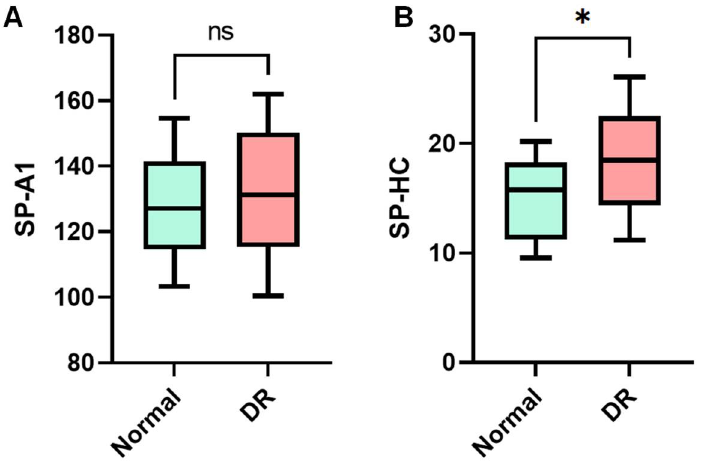
Figure 4. Comparison between diabetic retinopathy (DR) subjects and normal controls in ( A ) SP-A1 and ( B ) SP-HC. Asterisk * indicates statistically significant ( p < 0.05) between normal controls and DR cohorts.